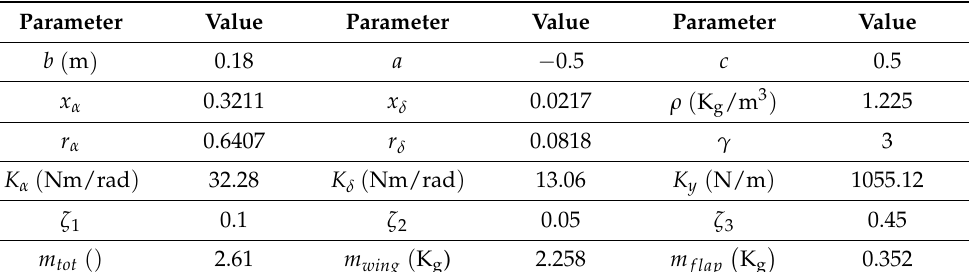
Table 1. 3DOF airfoil data.